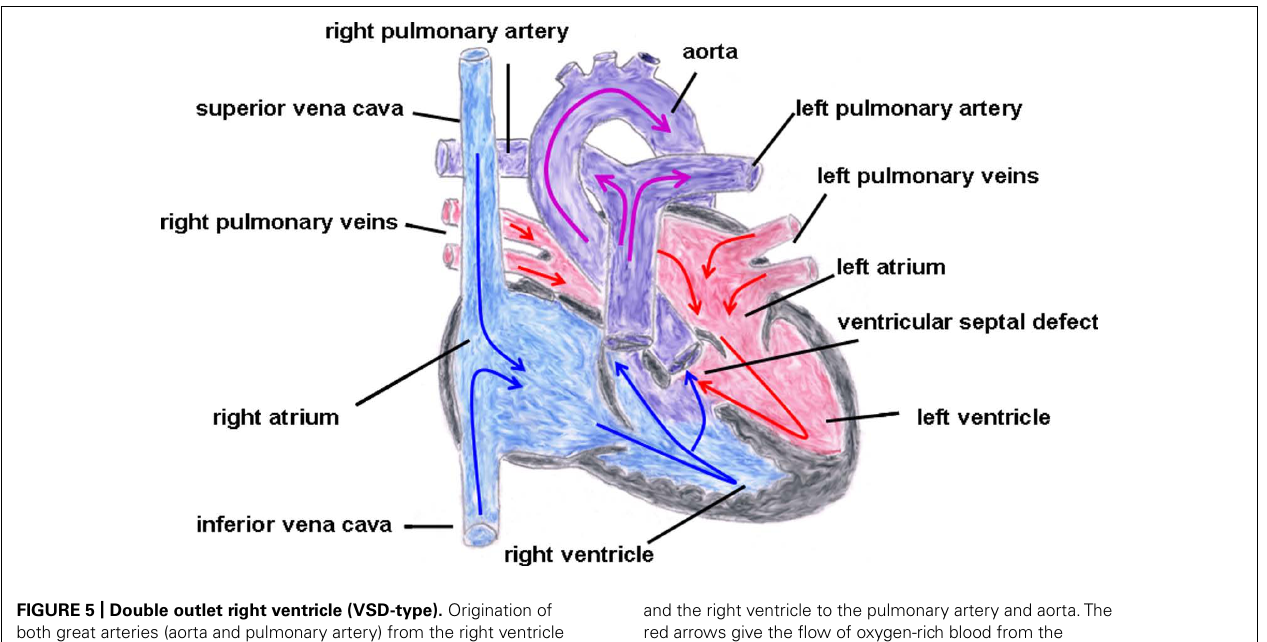
and the right ventricle to the pulmonary artery and aorta.The red arrows give the flow of oxygen-rich blood from the pulmonary veins via the left atrium, the left ventricle to the